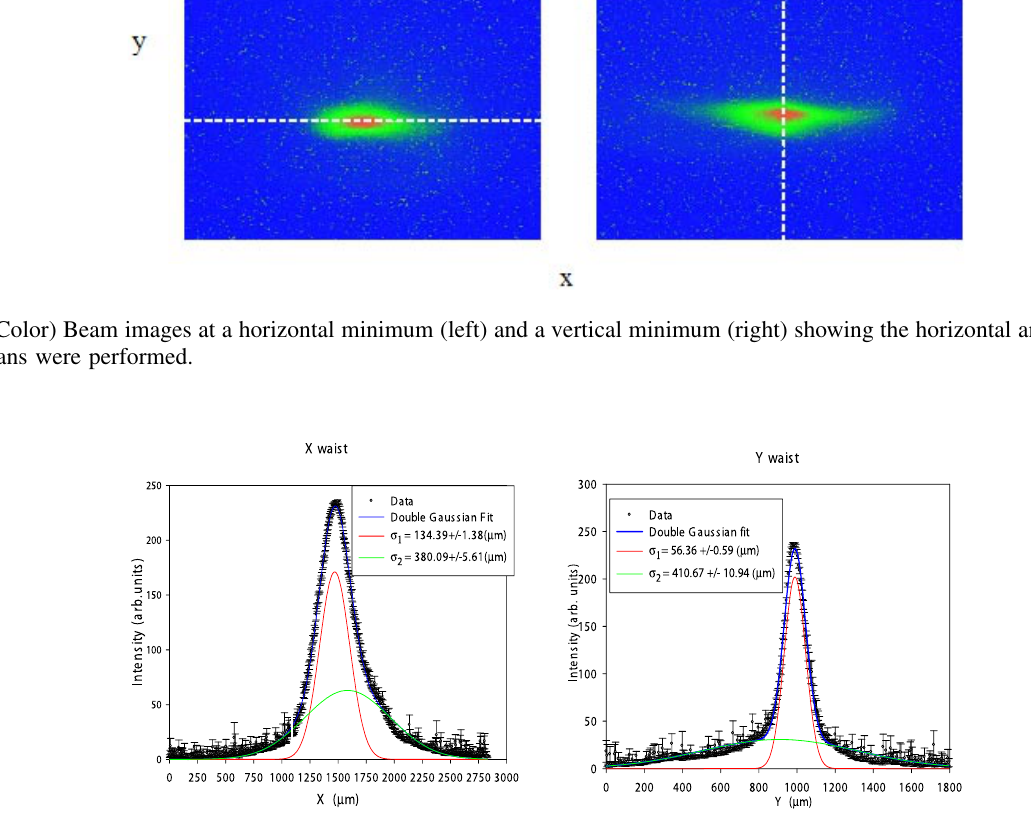
FIG. 10. (Color) Averaged line scans at a horizontal waist (left) and a vertical waist (right) along with double Gaussian